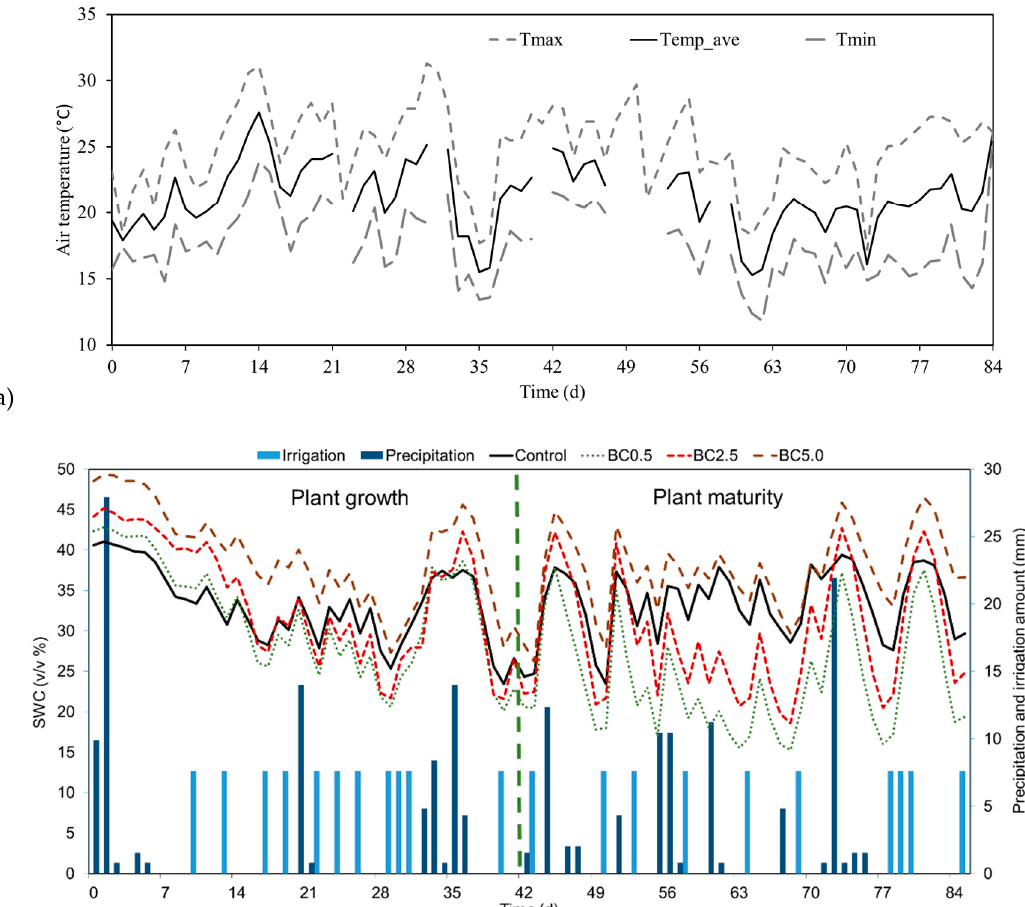
Figure 3. ( a ) Air temperature changes over time during the experiment. ( b ) Soil water content (SWC) changes in the different treatments over time. Values represent daily average